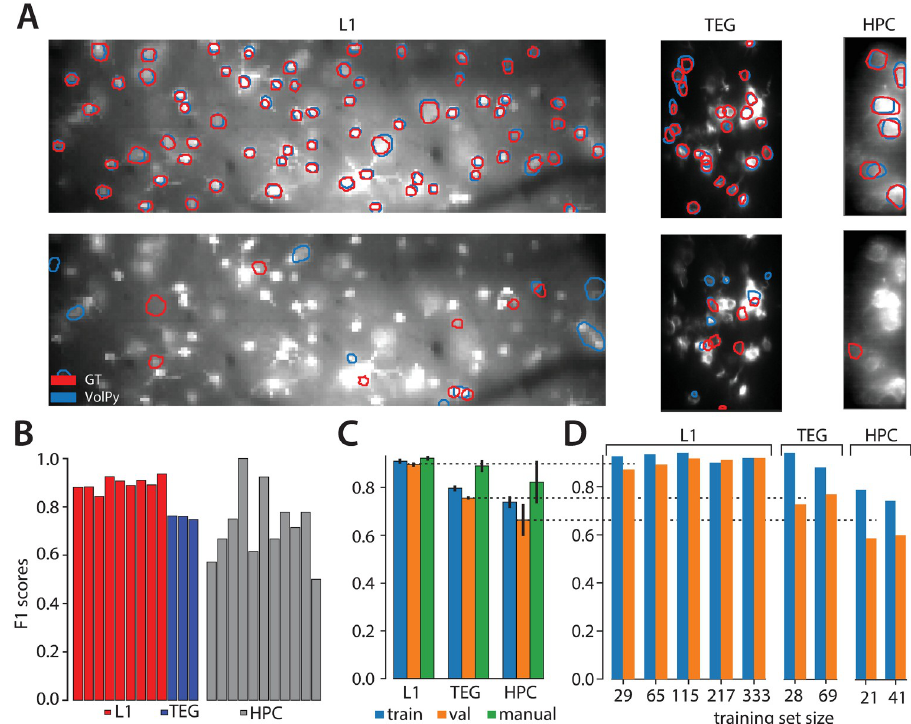
Fig 3. Evaluation of VolPy performance. (A) Example of VolPy segmentation results against three manually annotated datasets (mouse sensory cortex left, larval zebrafish tegmental area center, and mouse hippocampus right). Ground truth was built from three different annotations. Matched and mismatched neurons between VolPy (blue) and ground truth (red) were shown in upper and bottom panels respectively. (B) F 1 score of VolPy for all evaluated datasets in validation. (C) Average F 1 score on training and validation sets grouped by dataset type. Results were provided for training, validation and human annotators (against consensus ground truth) (D) Performance of the network in function of training set size for each dataset